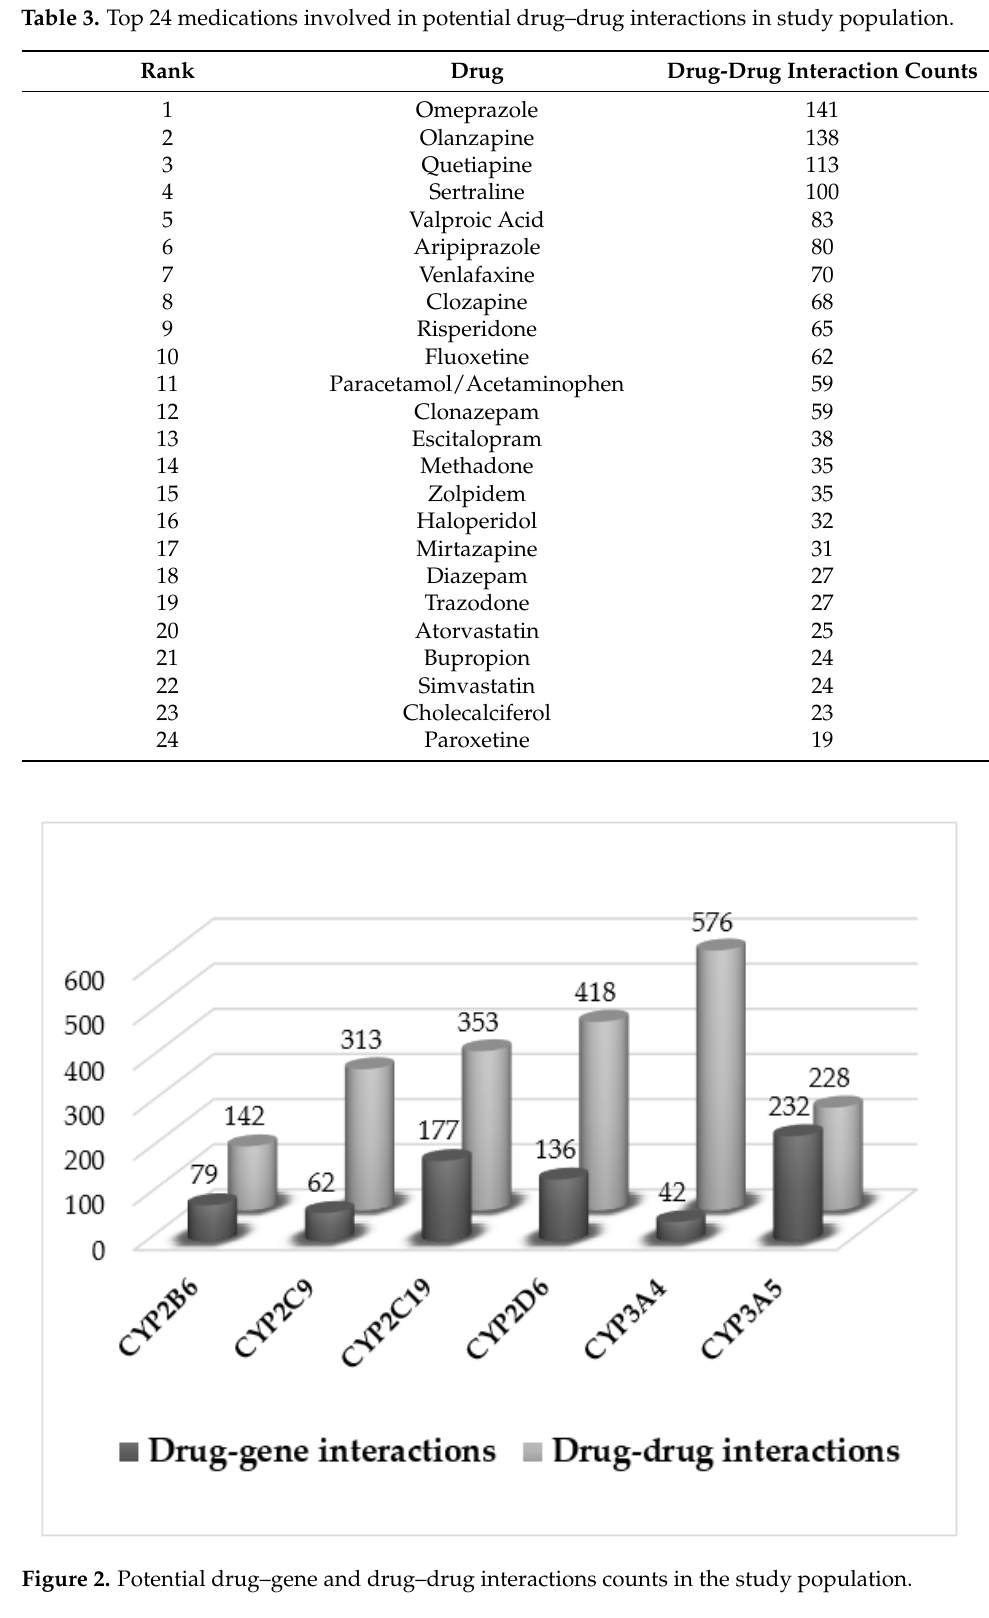
Table 4. Summary of variants tested